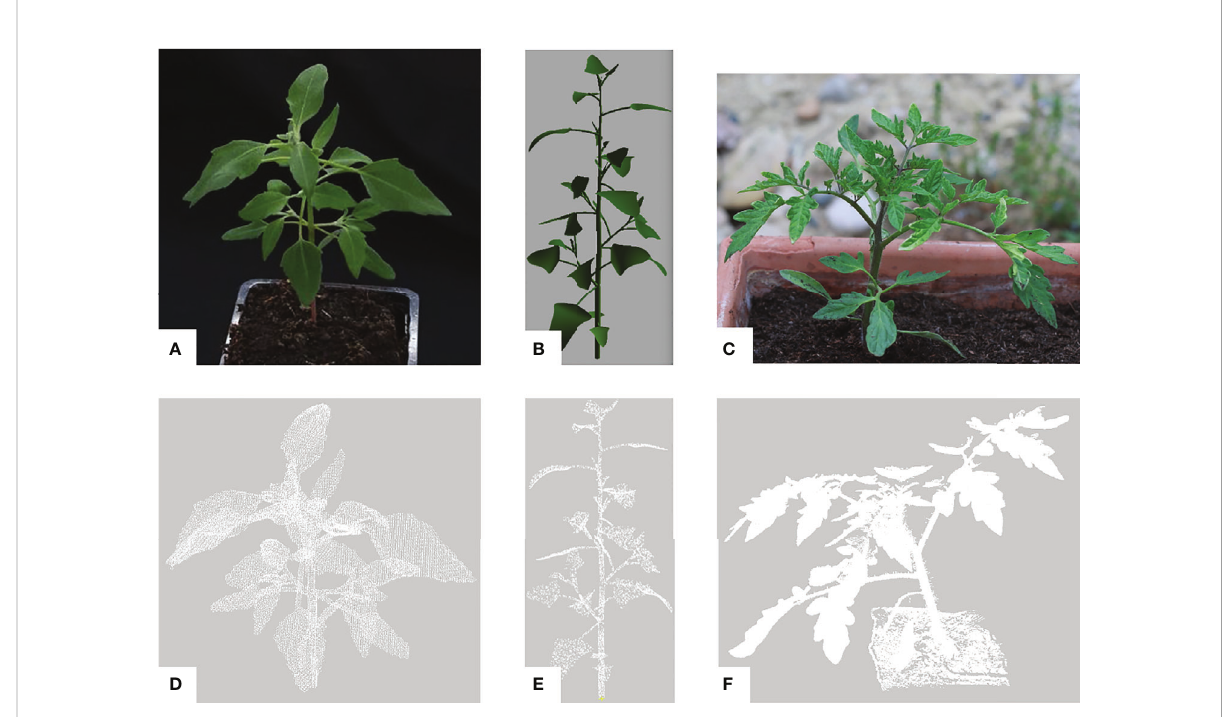
FIGURE 8 Plant data sets used for the assessment of our pipeline. Pictures of typical architectures from a: (A) real Chenopodium, (B) synthetic Chenopodium, (C) real tomato plant (our photo) illustrating the Pheno4D data set from Schunck et al. (2021). Corresponding raw point clouds processed by our pipeline are respectively shown in (D-F) . Point clouds (D, E) have the same view angles as pictures (A, B)